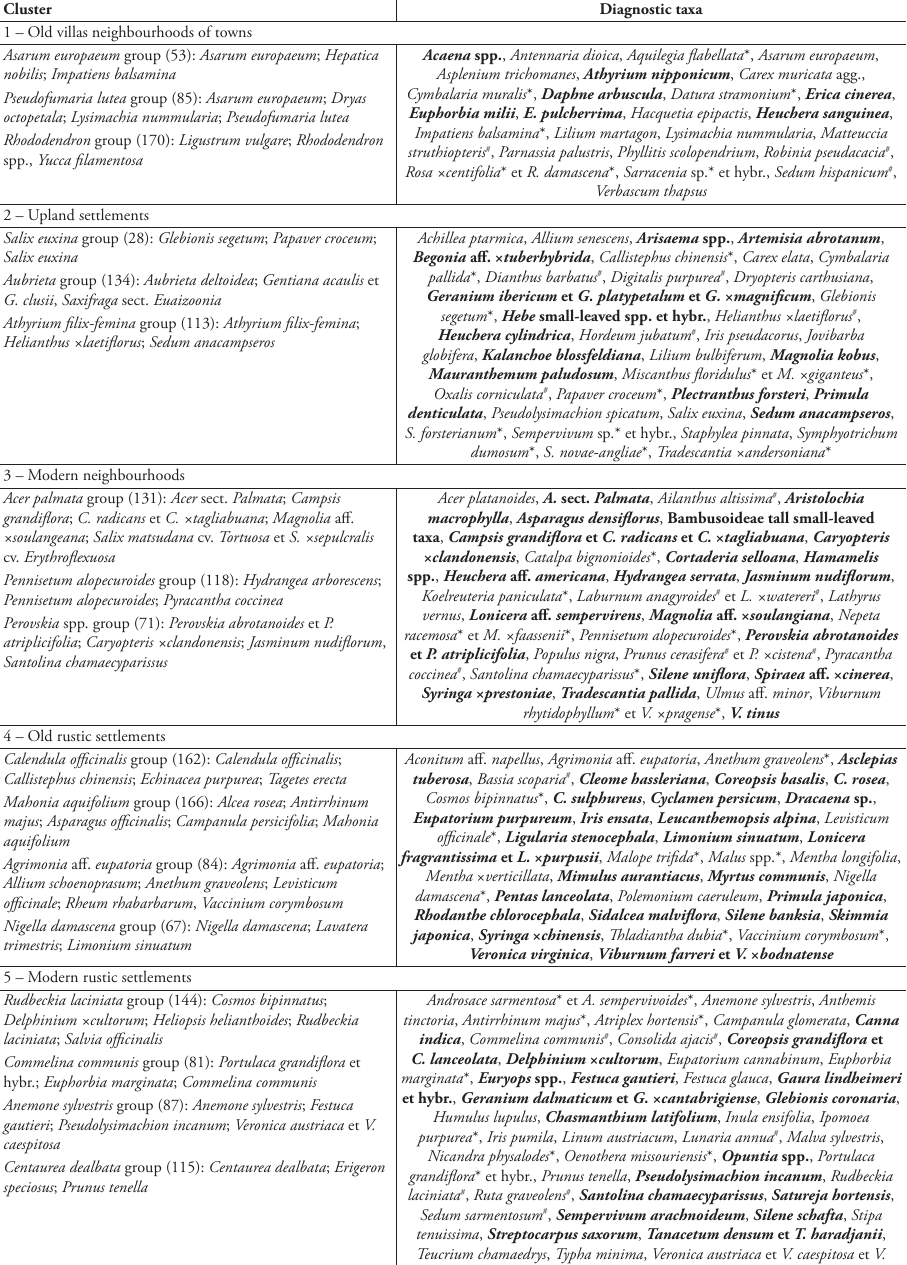
Table 1. Lists of diagnostic taxa composed of 17 COCKTAIL species groups (i.e. five clusters). The num- bers of sites selected by a species group are presented in brackets. Planted species (in bold), casual aliens (*), naturalised incl. invasive aliens ( #